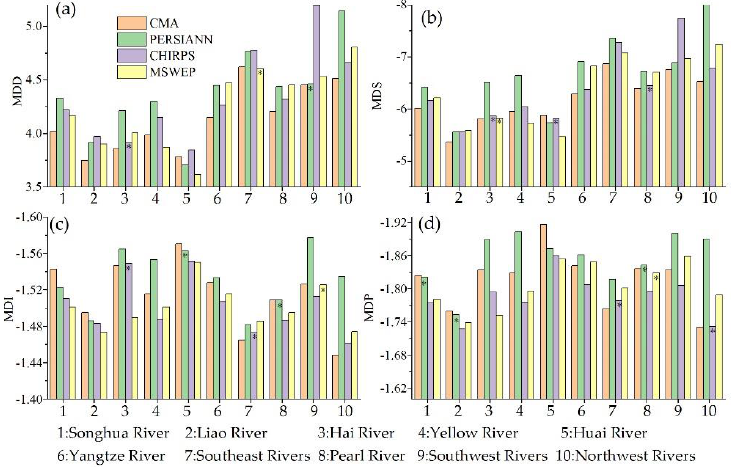
Figure 11. Mean values of the four drought characteristics in the first-level rivers based on SPI6 during 1983 – 2019. The * in the bars indicate that there no significant differences between the RSPE and CMA at the level of p = 0.01. The mean drought duration (MDD), mean drought severity (MDS), mean drought intensity (MDI), and mean drought peak (MDP) are shown in (a)-(d), respectively. The MDD over mainland China was 4.24 months, and the smaller values were mainly located in the northeastern and central plains of China (Basins 1 – 5), while the higher val- ues were found in southeastern and western China (Basins 6 – 10; Figures 10a and 11a). The three RSPEs generally overestimated the MDD, especially for PERSIANN, with an 8.7% larger MDD than the CMA data (Figure 10b). Although CHIRPS and MSWEP could rea- sonably capture the mean value of MDD, they also exhibited evident spatial divergences. For example, many overestimated areas were found in the northwest regions (Figure 10). At the basin scale, the largest MDD values of PERSIANN and CHIRPS were found in the northwestern and southwestern rivers, respectively ( p < 0.001). The best performances of PERSIANN, CHIRPS, and MSWEP were found in the southwestern, Hai, and southeast- ern rivers, respectively (Figure 11a). As the drought severity (DS) is accumulated from the SPI6 of all drought months, a longer drought duration (DD) can cause greater severity. Therefore, the MDS of each pre- cipitation dataset shared similar spatial distribution and basin statistical values with their corresponding MDD (Figures 10e – h and 11b). For example, PERSIANN overestimated drought severity by approximately 13.4% over mainland China, with an especially obvi- ous overestimation in the northwestern rivers (24.8%) (Figures 10f and 11b). CHIRPS and MSWEP could reasonably capture the mean MDS of the CMA data, but they generally overestimated the drought severity. CHIRPS performed well in the Hai, Huai, and Pearl rivers (Basins 3,5, and 8, respectively; Figures 10g and 11b). In terms of the mean drought intensity (MDI), CHIRPS outperformed the other two products in reproducing the spatial pattern. Specifically, CHIRPS could perfectly repro- duce the patterns of high drought intensity in the semi-humid and semi-arid climatic tran- sition areas (Figures 1b and 10i,k). On the other hand, both PERSIANN and MSWEP had difficulties in reasonably capturing the spatial distribution of drought intensity over the CMA data. At the basin scale, PERSIANN performed best in the Huai and Pearl rivers (Basins 5 and 8, respectively), CHIRPS in the Hai and southeastern rivers (Basins 3 and 7, respectively), and MSWEP in the southwestern rivers (Basin 9; Figure 11c). Therefore, the optimal product in each basin can be recommended for the detection and early warning of drought intensity. Mean drought peak (MDP) can reflect the extremity of drought events. It plays a cru- cial role in crop growth and water resource management, because whether the crops can